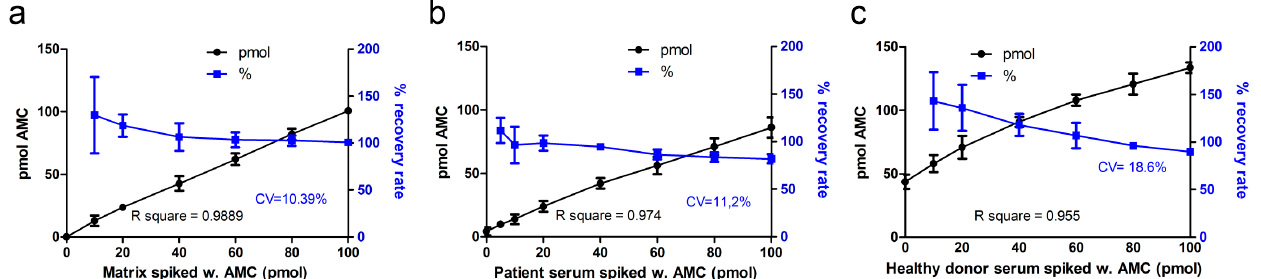
Figure 2. Accuracy of AMC detection. Inter-assay accuracy was determined by spiking of samples with defined amounts of AMC. ( a ) artificial serum matrix; ( b ) AGU patient serum, or ( c ) serum of healthy donors. The samples were supplemented with 10–100 pmol of AMC and incubated for 24 h to mimic the AGA activity assay protocol. Nominal and measured AMC values were plotted against each other (black symbols, left axis). R-square was calculated by linear regression analysis, and recovery rate (blue symbols, right axis) was computed from the determined value and expressed as % from the true value. The values represent the mean ± SD of three independent experiments.